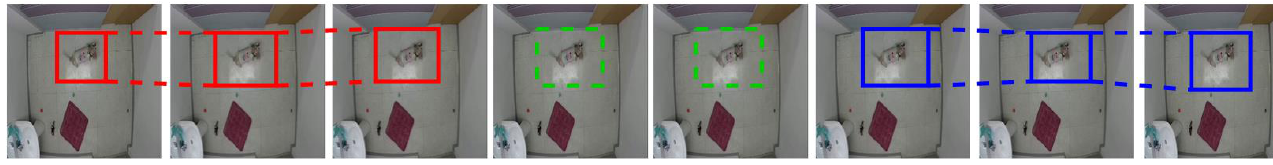
Figure 3. Example of linking two tubelets, 𝑇𝑖 in red and 𝑇𝑗 in blue, and generating missed detections (green dotted boxes).